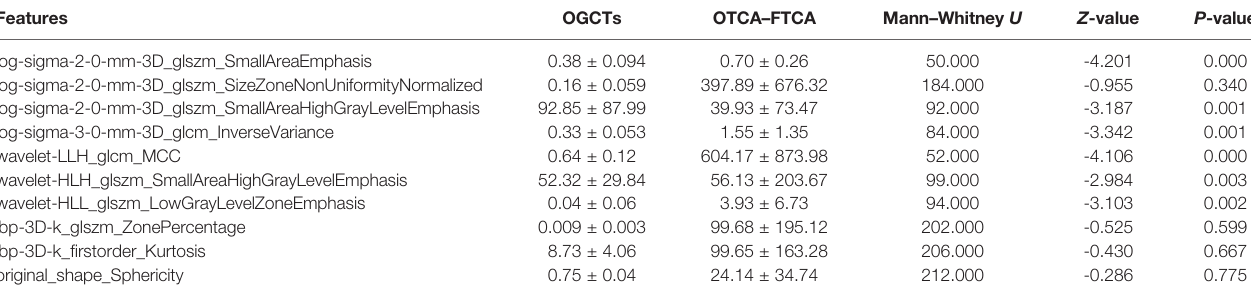
TABLE 4 | Results of the univariate analysis of texture features that were signi fi cantly different between the OGCTs and OTCA – FTCA groups.